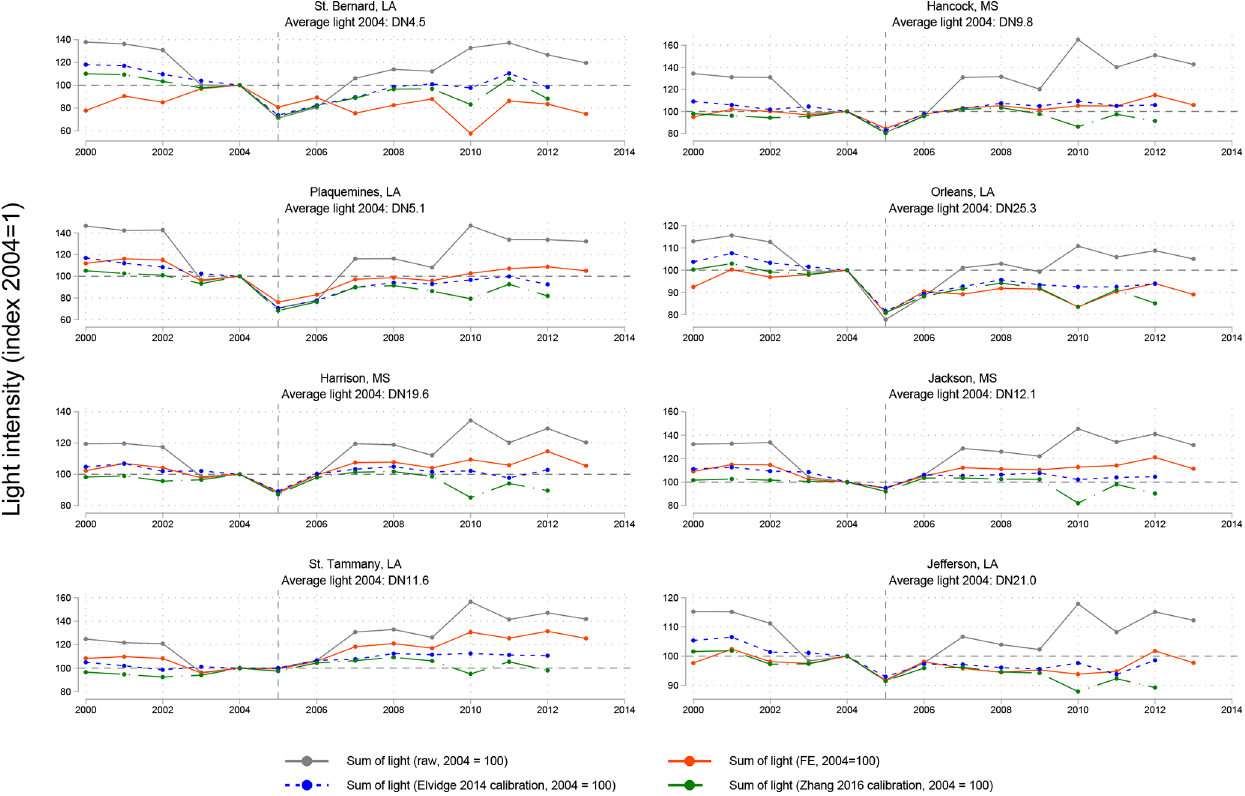
Figure B2. Corrected night light data (indexed to 2004 = 100). Four series: raw data (gray), fixed-effect adjustment, invariant area calibration (Elvidge et al., 2014), and global consistent bias calibration (Zhang et al., 2016). Total sum of light by county, indexed to 2004 =